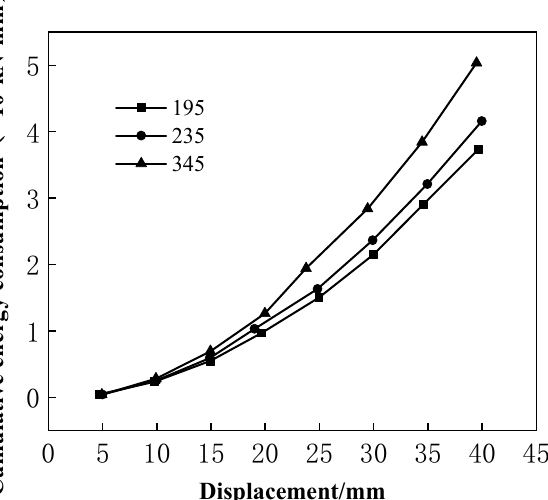
( b ) Figure 17. Hysteretic curve and skeleton curve under different energy dissipation ring strength. ( a ) Hysteretic curve. ( b ) Skeleton curve. In the elastic stage of the first loading, it can be seen that the hysteretic curves and skeleton curves of PSCFST piers with different material strengths of energy dissipation rings basically coincide, indicating that the overall stiffness has nothing to do with the material strength when it does not enter the damage stage at the beginning. The slip sec- tion of unloading is basically the same, indicating that the influence of material strength